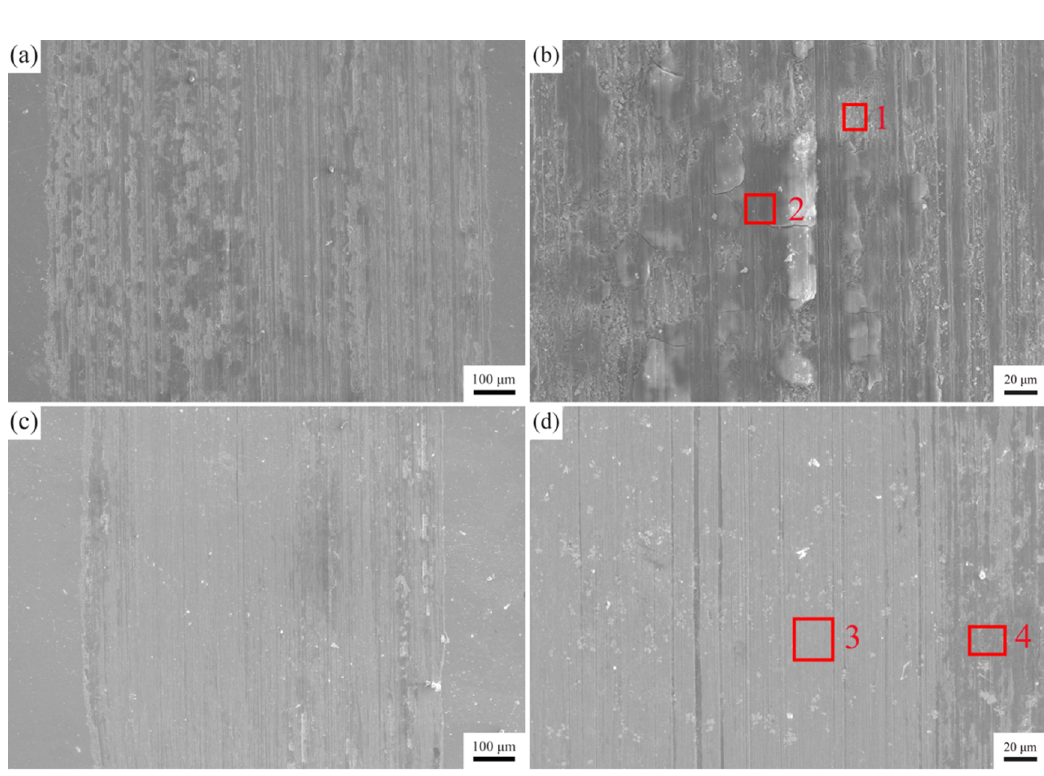
Figure 7. Wear tracks of the substrate (( a ) and ( b )) and Coating III (( c ) and ( d )) subject to friction in air. Table 5. Chemical compositions of marked zones shown in Figures 7 and 11.